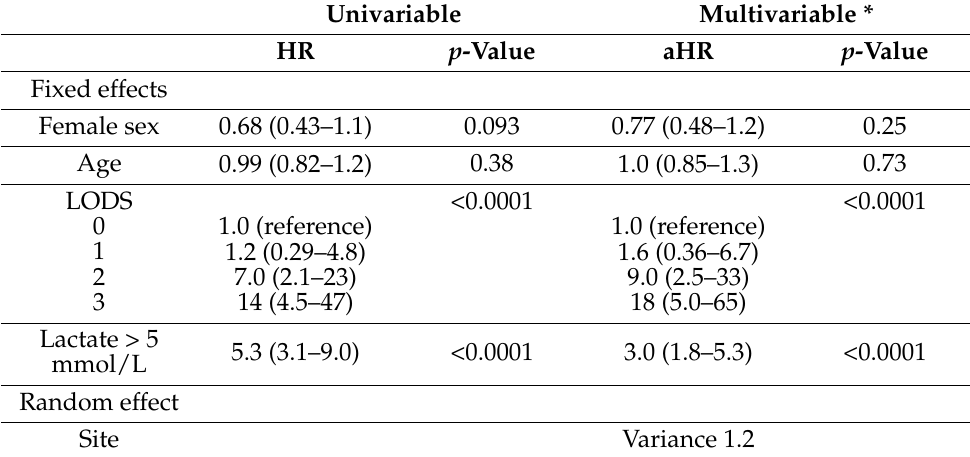
Table 2. Univariable and multivariable hazard ratios for mortality among children with malaria and respiratory